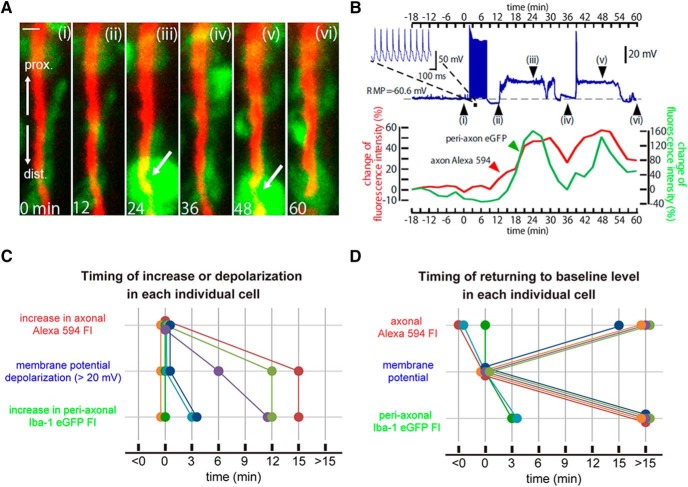
Microglial wrapping of an axon and rescuing the depolarized somatic membrane potential. A, Time-lapse images of an axon (red) and surrounding microglial processes (green) before (Ai) and at various times as indicated (Aii–Avi) after a 6 min period of supramaximal AP stimulation. Scale bar, 5 µm. Arrows at Aiii and Av indicate extensive microglial accumulation around the axon. B, Vm (top) and changes in relative axonal (red) and periaxonal microglia (green) FI (bottom panels) obtained from the experiment shown in A. Bi–Bvi correspond to times shown in A. Note that the Vm and FI are shown on the same timescale to illustrate the temporal associations among Vm depolarization, axonal swellings, and the extensive accumulation of microglial processes around the axons that precedes repolarization and reduced swelling. C, D, The temporal relationships among changes in axonal volume, membrane potential, and the fluorescence intensity of periaxonal microglial processes. The graphs plot data for each neuron of C; the relative times of Vm depolarization and how this relates to increased axonal swelling and microglial FIs; and how the recovery of Vm relates to the recovery of axonal swelling (top) and microglia FI (bottom; D). In C and D, each colored line (with associated points) was obtained from a single experiment (n = 7). The criterion for FI increase was >5% from the prestimulus intensity, and for depolarization was >20 mV from resting Vm. Vm recovery (time = 0 in D) was defined as the return to within 10 mV of the initial resting Vm, and microglial FI recovery (process retraction) was defined as the return to within 5% of the initial value.